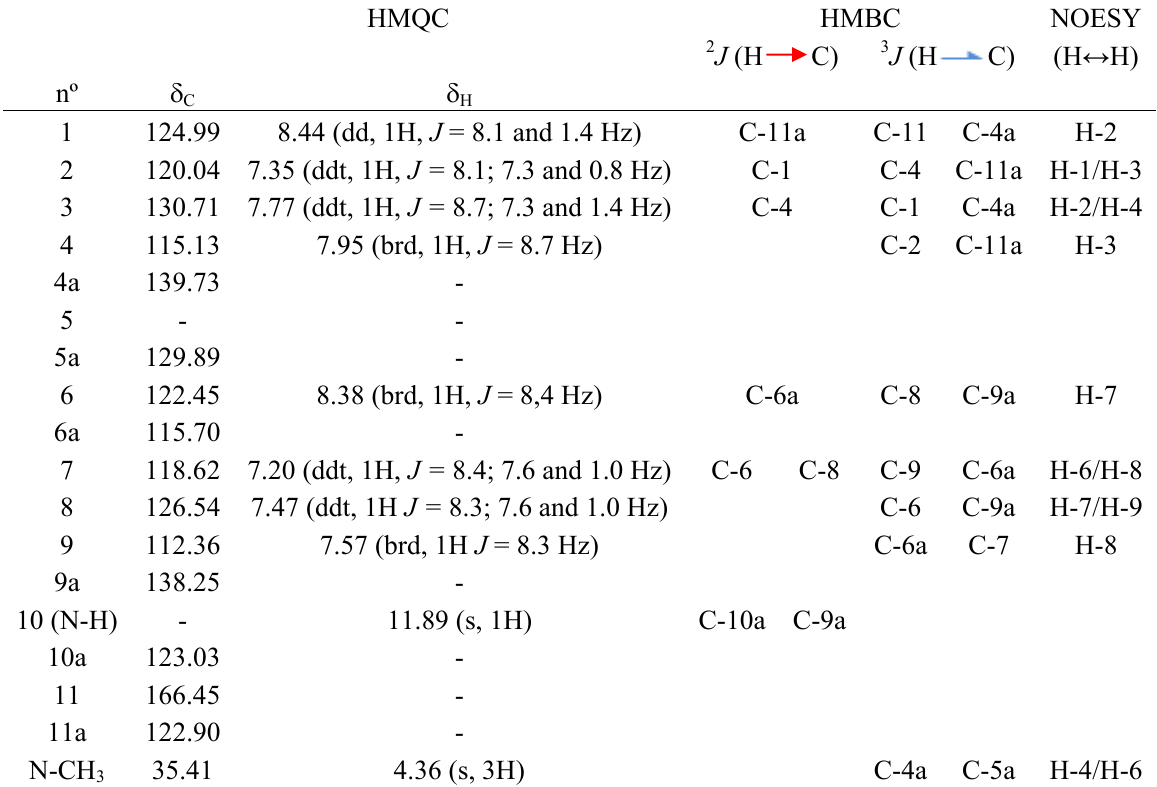
Table 1. 13 C-NMR (125 MHz), 1 H-NMR (500 MHz), HMQC, HMBC and NOESY data of ,  ppm). cryptolepinone ( 8 ) (DMSO- d 6